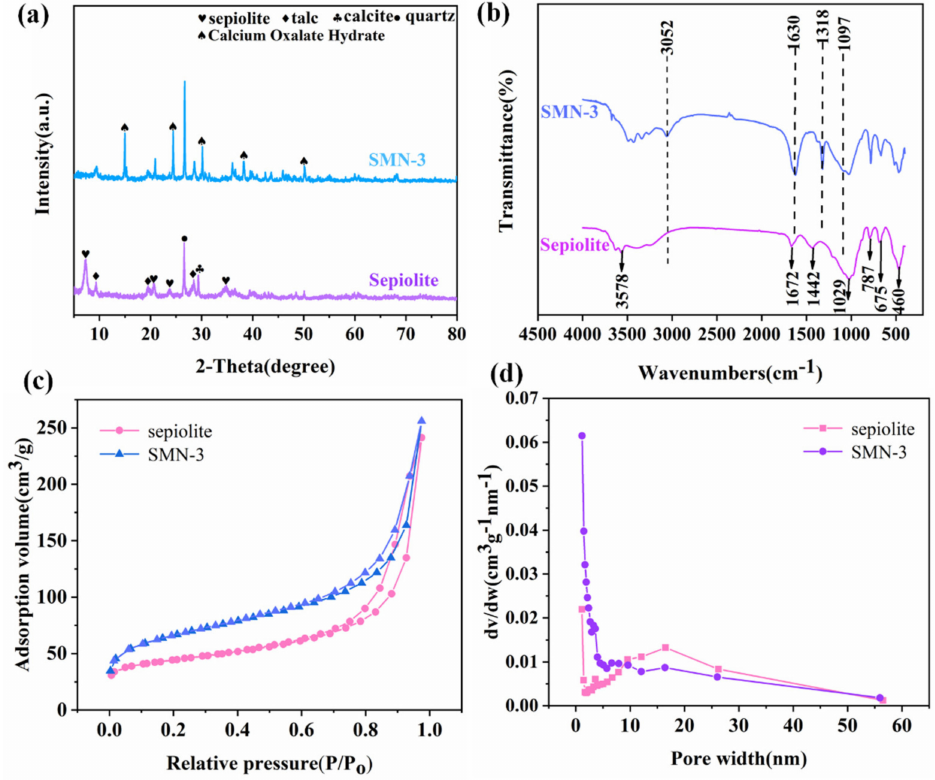
Figure 2. ( a ) XRD patterns of Sepiolite and SMN-x3; ( b ) FTIR; ( c ) N 2 adsorption/desorption isotherms; ( d ) Pore diameter distribution